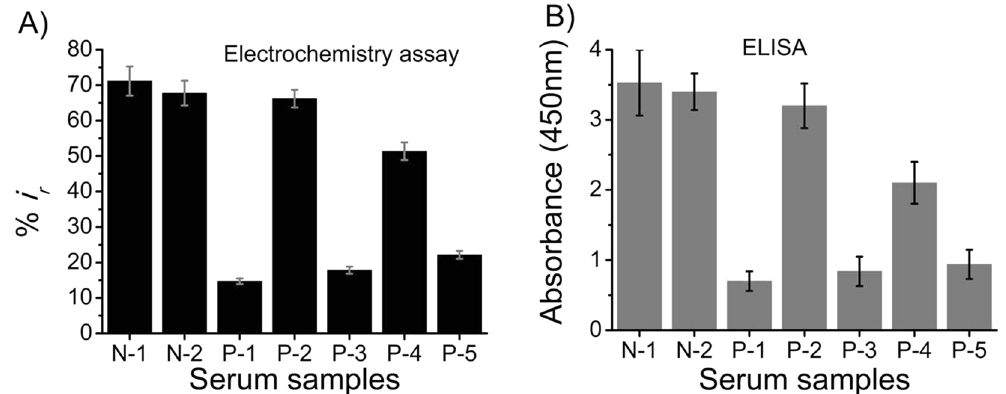
Figure 6. Clinical sample analysis. Comparison of relative ( A ) current change and ( B ) absorbance response between colon cancer patients (P1-P5) and healthy individuals (N1, N2). Each data point represents the average of the three separate trials ( n = 3) and error bars represents the standard deviation of measurements within